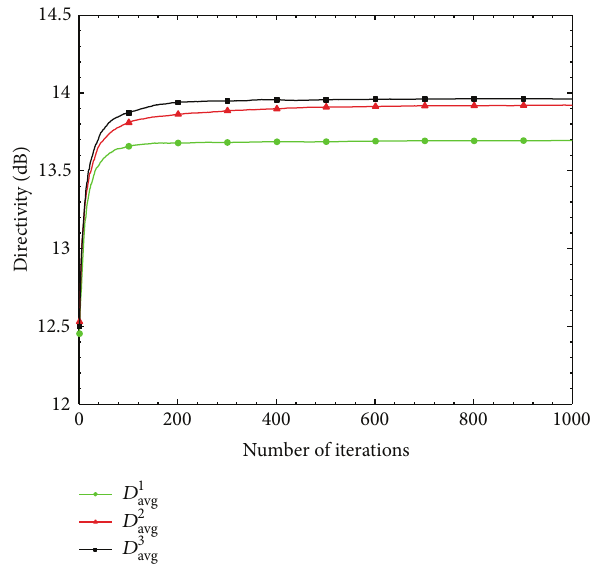
Figure 25: Time-average directivity variation of three methods for JSCIS— 𝐷 𝑘 represents the time-average directivity and 𝑘 represents the method used where 𝑘 = 1 : SBL, 𝑘 = 2 : SR, 𝑘 = 3 :